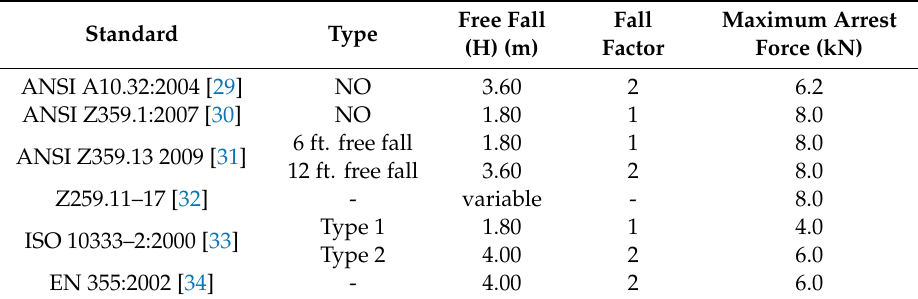
Table 1. Maximum arrest force according to di ff erent standards.